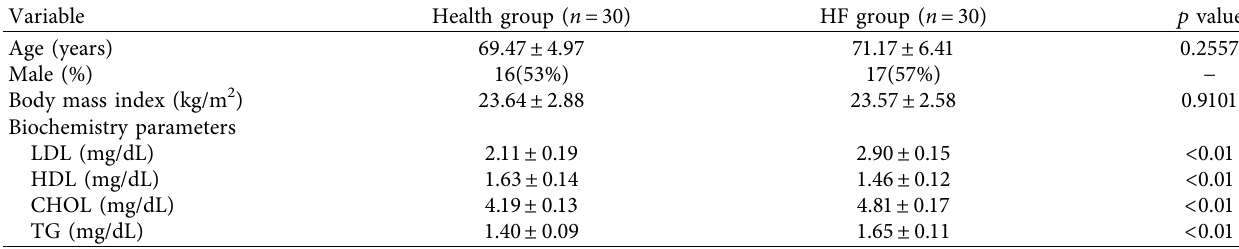
Table 1: Baseline characteristics of the study